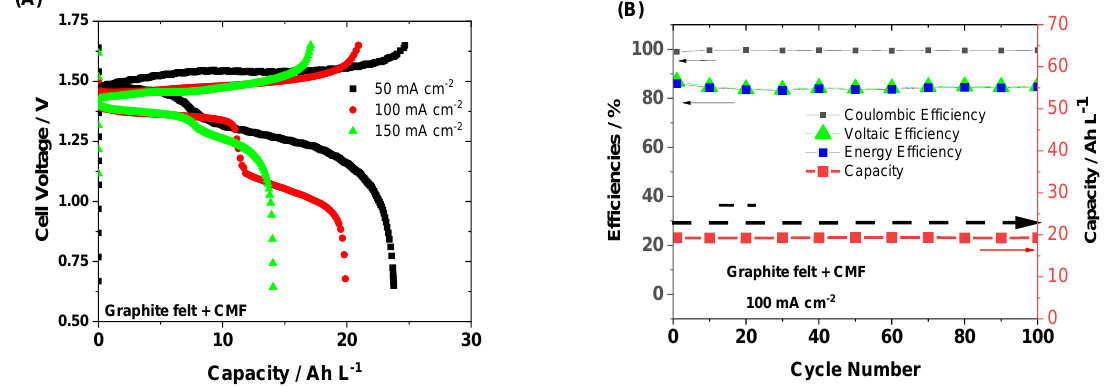
Figure 4. ( A ) Galvanostatic charge and discharge (GCD) at different current densities: 50, 100, and 150 mA cm − 2 . ( B ) GCD of H/Mn for 100 cycles with efficiencies and electrolyte capacity utilization for CMF and felt. Electrolyte 1 M MnSO 4 , 1 M Ti(SO 4 ) 2 , and 3 M H 2 SO 4 . Hydrogen 100 mL min − 1 and liquid flow rate of 50 mL min − 1 .